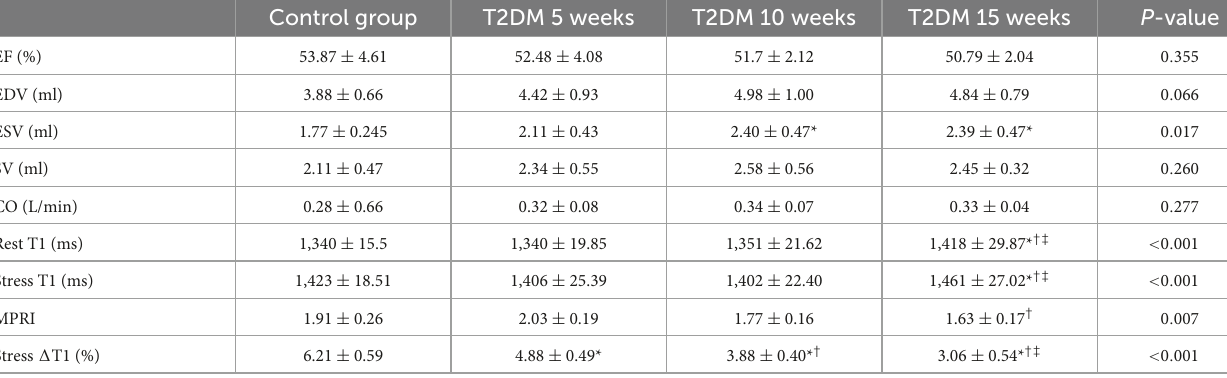
TABLE 2 Cardiovascular magnetic resonance results in controls vs. T2DM groups.